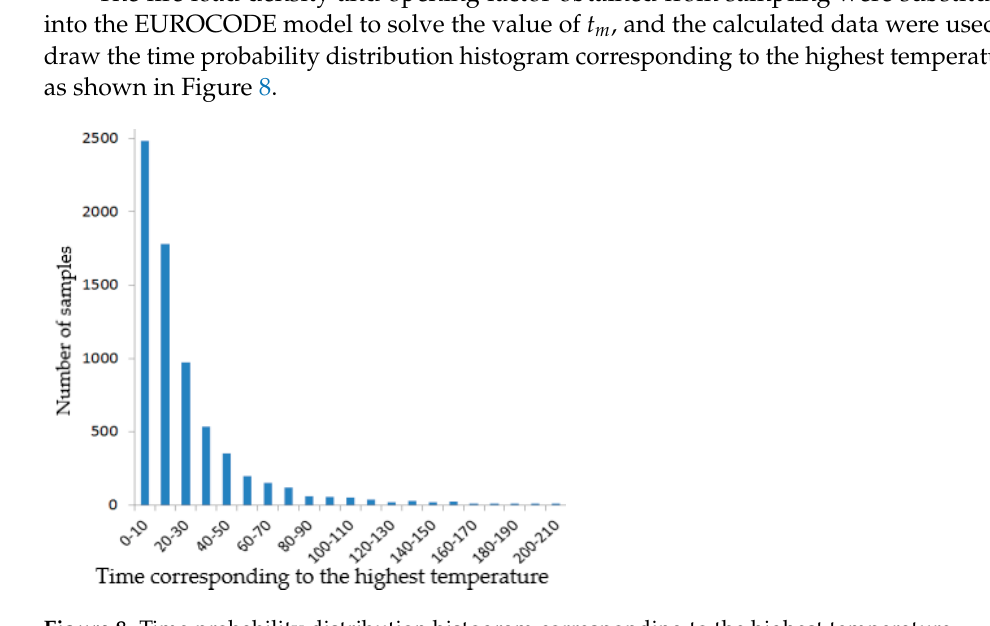
Figure 8. Time probability distribution histogram corresponding to the highest temperature.